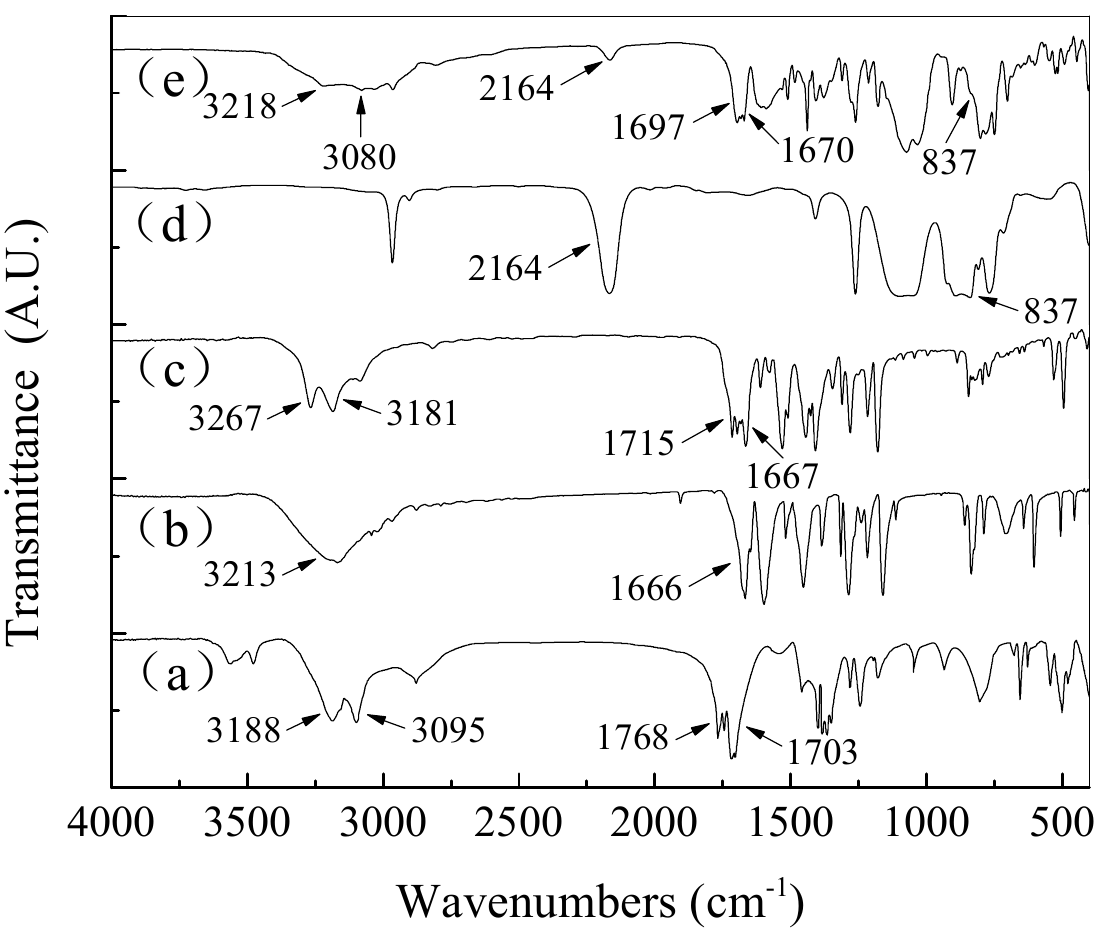
Figure 1. FTIR spectra of barbituric acid ( a ), 4-hydroxybenzaldehyde ( b ), 5-(4-hydroxybenzyli- dene)pyrimidine-2,4,6-trione ( c ), PMHS ( d ), and barbituric acid-based polysiloxane ( e ).